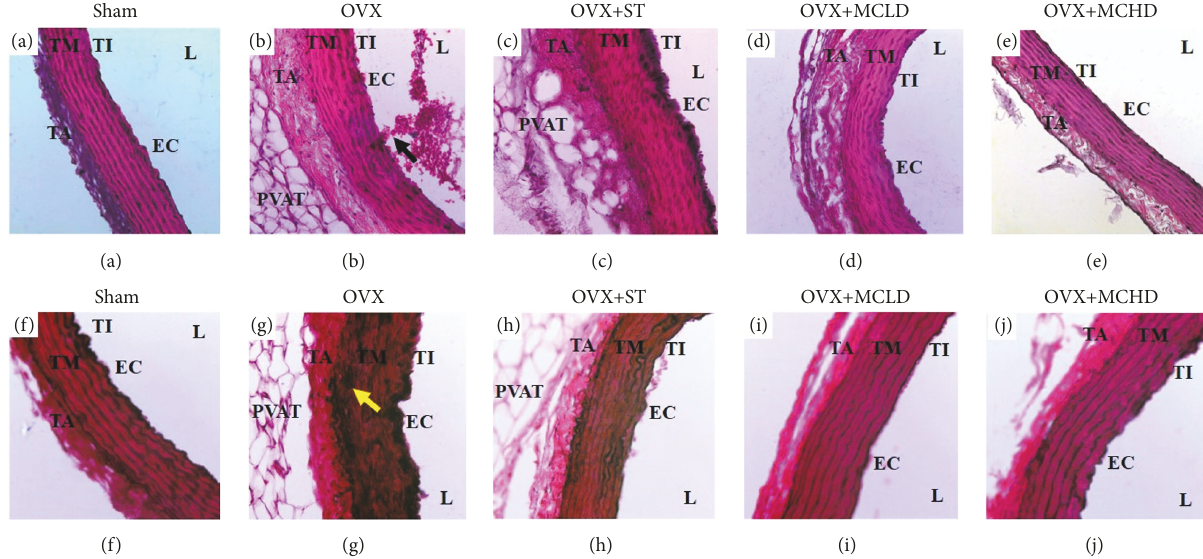
Figure 1: Photomicrograph showing the effect of MC leaf extract on the aorta. (a-e) H&E staining of the rat aortae (X200). Note the presence of infiltratory cells along the aortic wall (arrow) and deposition of perivascular adipose tissue (PVAT) in the tunica adventitia of (b) OVX. (f-j) VVG staining of the rat aortae (X200) showing total disruption of the internal elastic laminae with thickening of the tunica media in (g) OVX. TI: tunica intima, TM: tunica media, TA: tunica adventitia, L: lumen, EC: endothelial